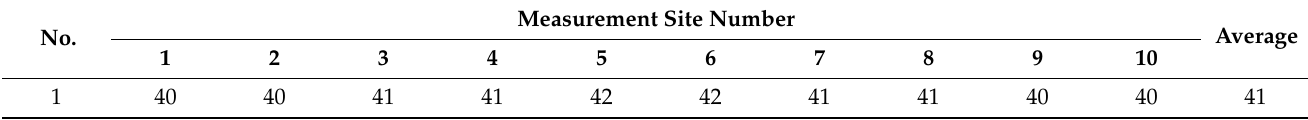
Table 3. Results of measurements of HRC hardness of the working part of the pick for roadheaders (Figure 11a). No.